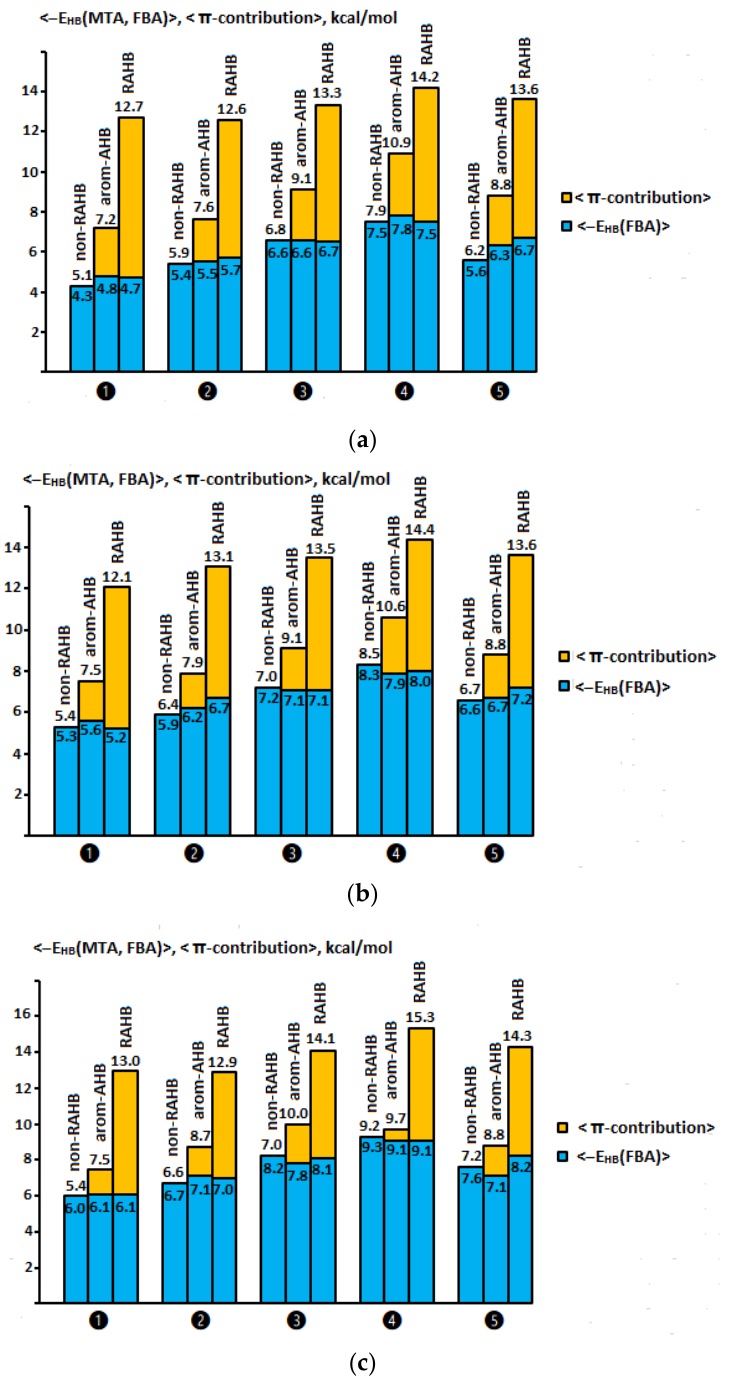
Figure 4. The average < − E HB (FBA)> IMHB energy estimated via the FBA method (blue) and the average < − E HB (MTA)> IMHB energy estimated via the MTA method (blue as σ‐ contribution and yellow as π‐ contribution) for compounds of the non ‐ RAHB, arom ‐ AHB, and RAHB clusters: range ρ BCP and V BCP — ❶ 0.030–0.035 a.u., ❷ 0.035–0.040 a.u., ❸ 0.040–0.046 a.u., ❹ 0.046–0.051 a.u., ❺